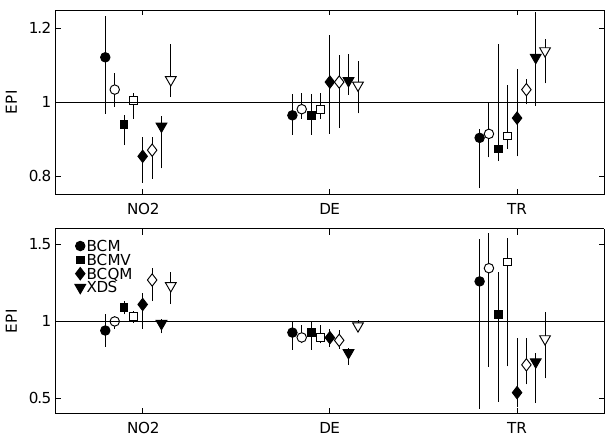
Figure 8. EPI for each BC method for NO2, DE, and TR for win- ter (top) and summer (bottom). The markers indicate the median and the lines represent the range covered by the 25th and 75th per- centiles. The results are shown for 1-day (filled markers) and 30- day (hollow markers) temporal aggregation. All the results are for 1-year threshold. The same symbols are used for the different down- scaling methods as in Fig. 7. Note the different scales used in the y axis for winter and for